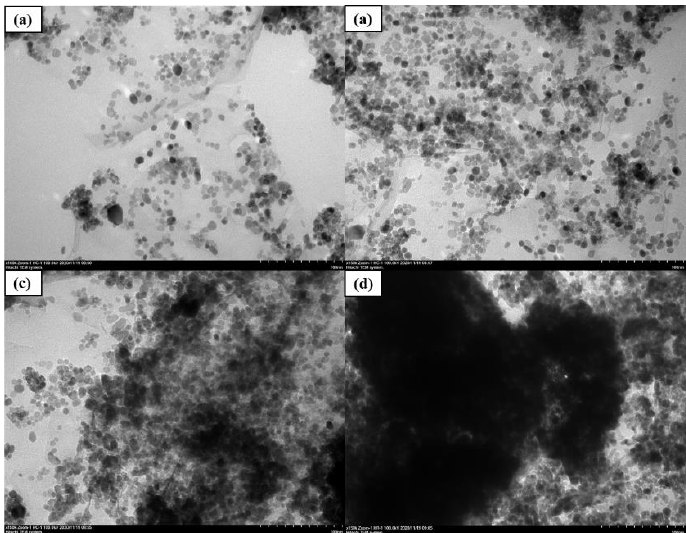
Figure 4. Micromorphological features of different mass ratio of CeO 2 -GO nanocomposites: ( a ) G2 SEM pattern; ( b ) G3 SEM pattern; ( c ) G4 SEM pattern; ( d ) G5 SEM pattern.